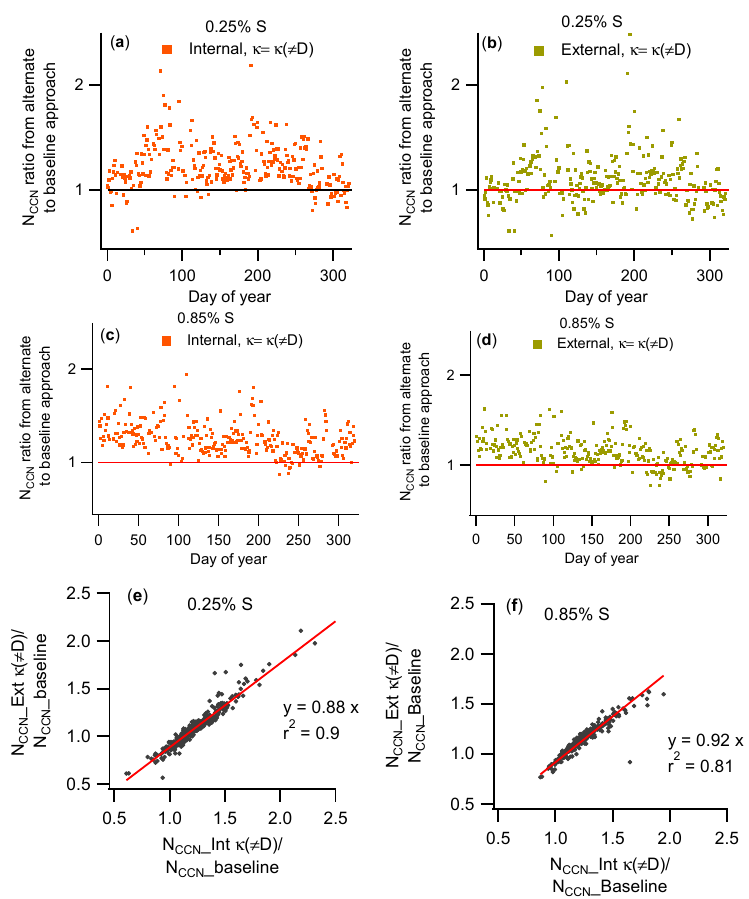
Figure 10. ( a – d ) Time series for 2011 of estimated N CCN relative to that from the baseline approach: ( a ) internal mixture, κ (cid:54) = κ (D) at 0.25% S; ( b ) external mixture, κ (cid:54) = κ (D) at 0.25% S ( c ) internal mixture, κ (cid:54) = κ (D) at 0.85% S; and ( d ) external mixture, κ (cid:54) = κ (D) at 0.85% S; ( e ) Scatter plot of N CCN ratio